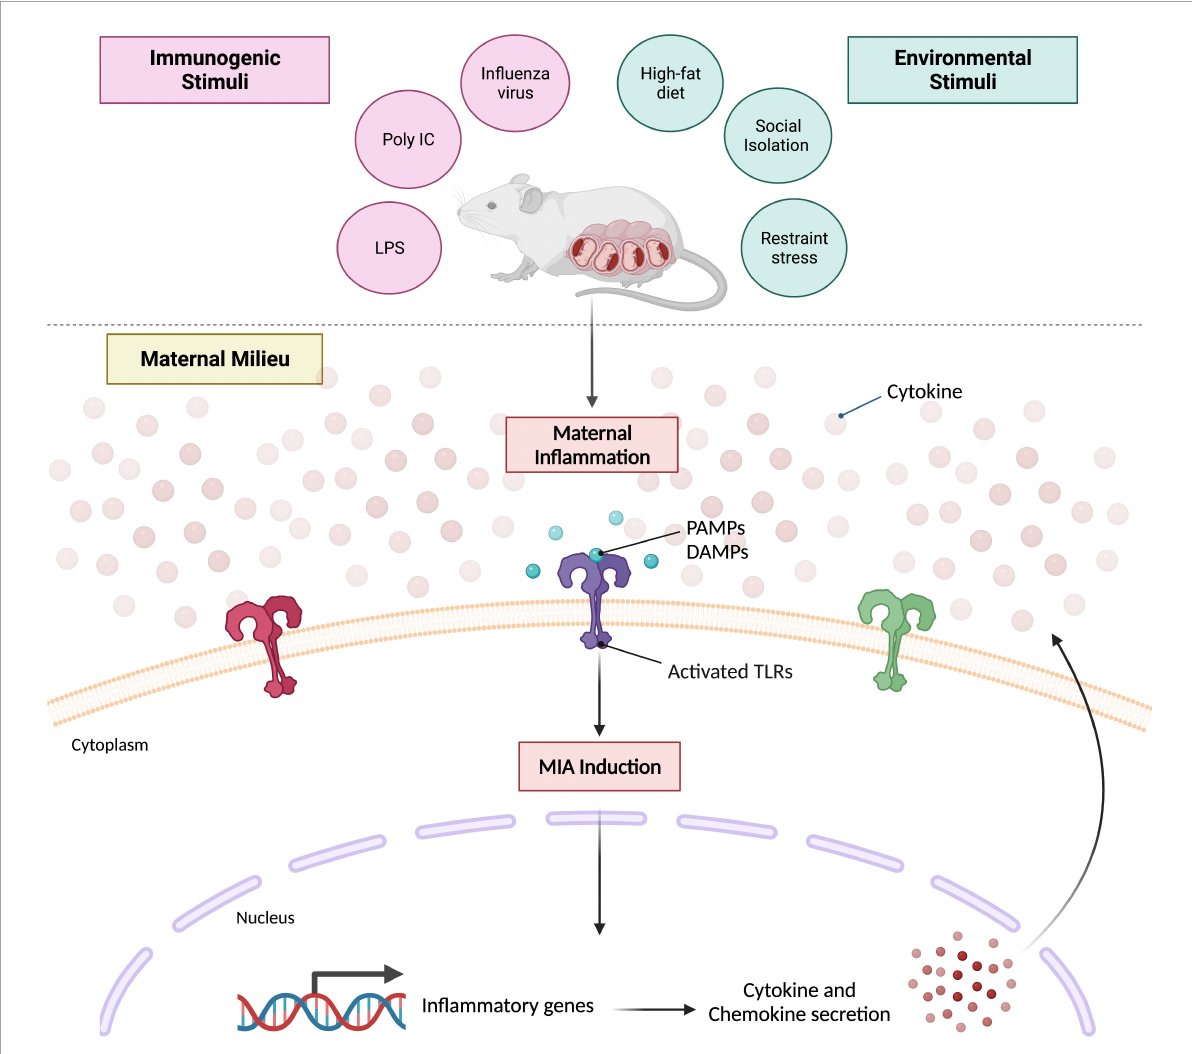
FIGURE1 Prevailing mouse model of maternal immune activation. Maternal inflammation can be induced during various periods of gestation via immunogenic or environmental stimuli. Characteristic immunogens used that elicit an acute, innate immune response include influenza strain A or B, poly I:C (high- or low-molecular weight) and LPS. Environmental stimuli typically used include high-fat diet regimens, social stress paradigms or restraint stress. Despite the nature of the stimulus itself, both converge on the same molecular mechanism that evokes maternal immune activation. Pathogen associated molecular patterns (PAMPs) and/or damage associated molecular patterns (DAMPs) are generated which activate various toll-like receptors (TLRs) that promote the transcription of several inflammatory genes; ultimately leading to perpetual cytokine and chemokine secretion within the maternal milieu. Created with